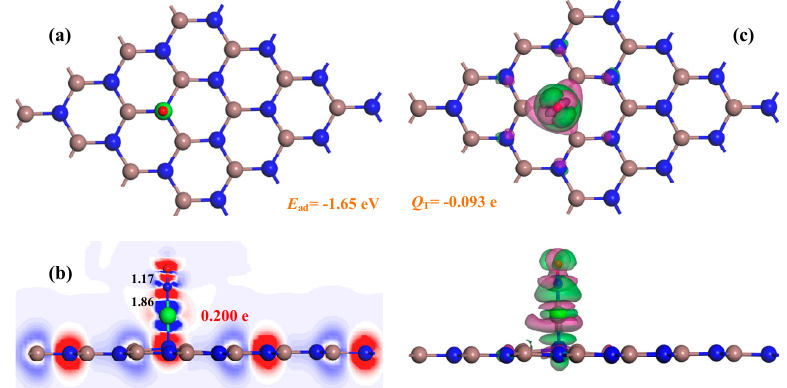
Figure 3. The most stable configuration ( a ), ELF ( b ) and EDD ( c ) for CO adsorption on the Pd-InN monolayer. The setting in EDD is same as Figure 2. The black values are bond length while the red value is the charge of the Pd dopant.